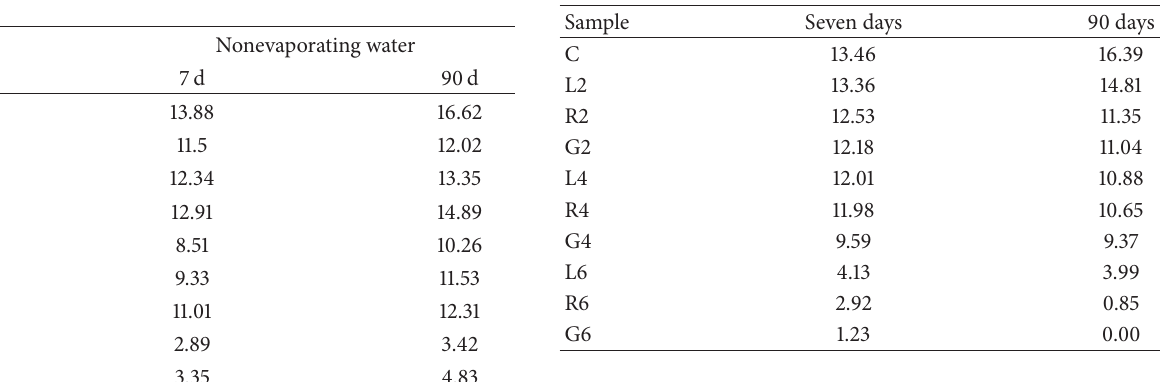
Table 5: CH content of the hydration products/mass, %.